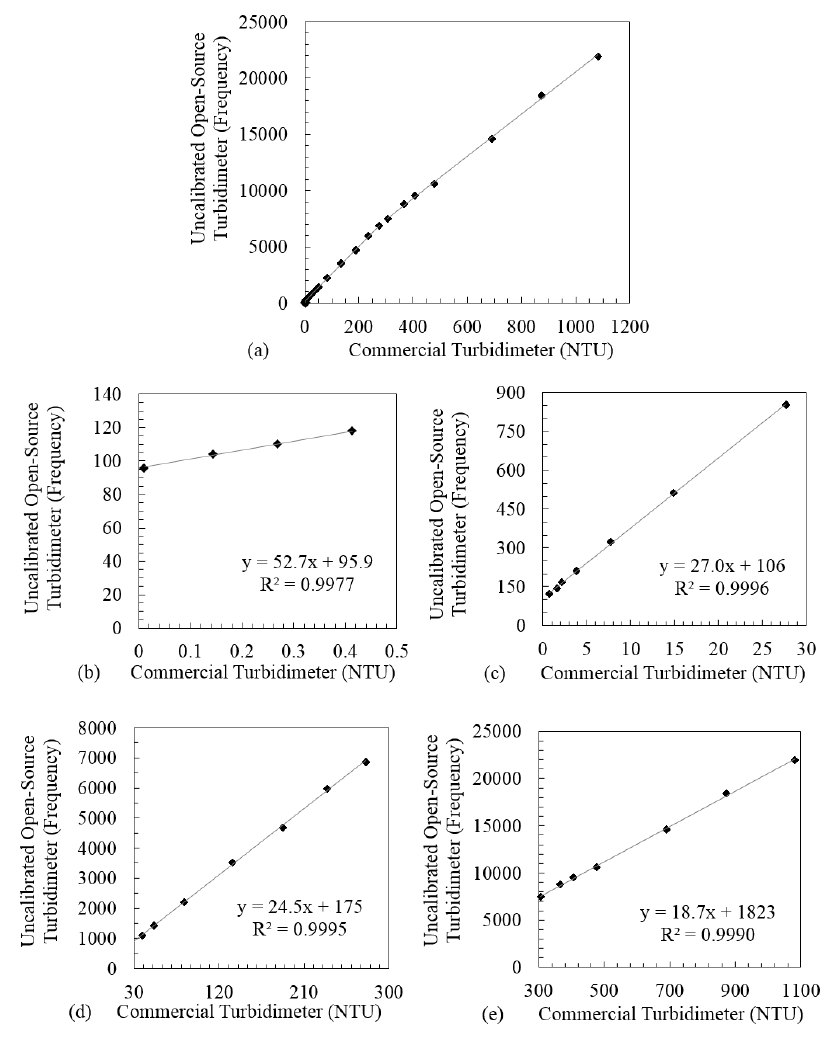
Figure 4. Comparison of averaged open-source turbidimeter and commercial turbidimeter measurements of 25 cutting oil suspensions, overall ( a ) and in four